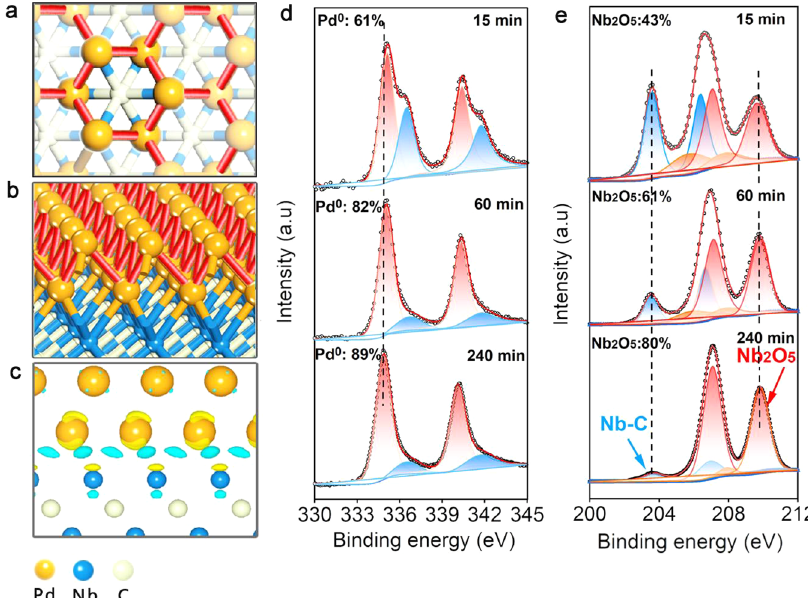
Fig.4|ElectronicpropertiesofPd/Nb 2 CMXenes.a ThetopviewofsimulatedstructuremodelofPd/Nb 2 C. b TheobliqueviewofsimulatedstructuremodelofPd/Nb 2 C. c Charge density difference of Pd atoms on Nb 2 C. d XPS spectra of the Pd 3 d level of Pd/Nb 2 C. e XPS spectra of the Nb 3 d